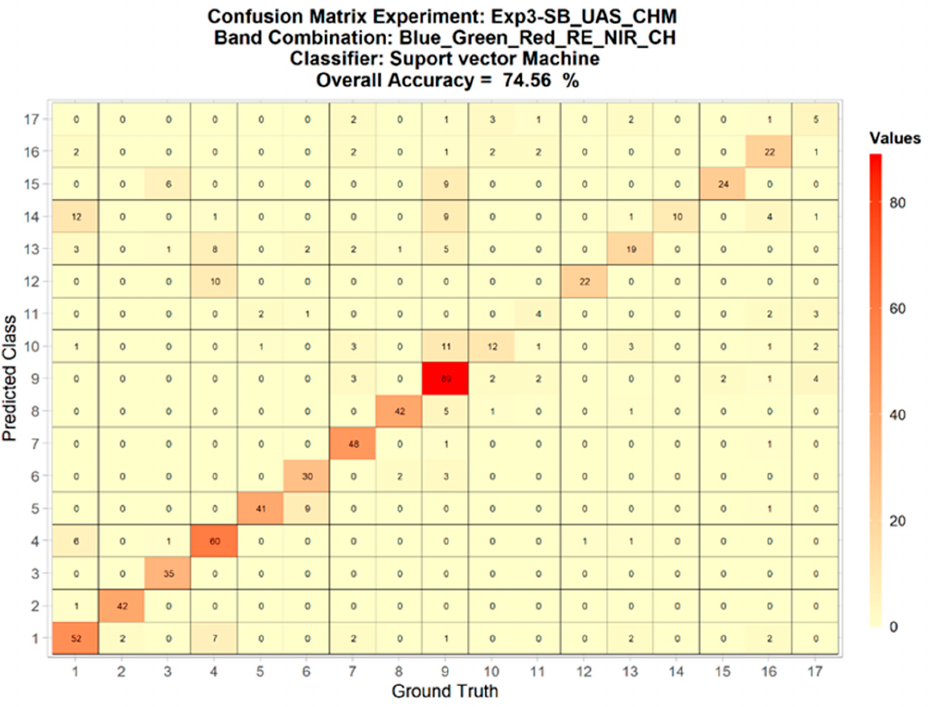
Figure A19. Confusion matrix for the best results obtained in Exp3-SB_ UAS_CHM, using the Support Vector Machine classifier (the Blue_Green_Red_RE_NIR_CH band combination).